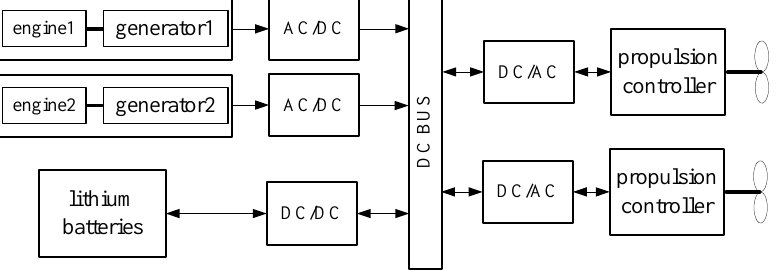
Figure 3. Block diagram of hybrid power